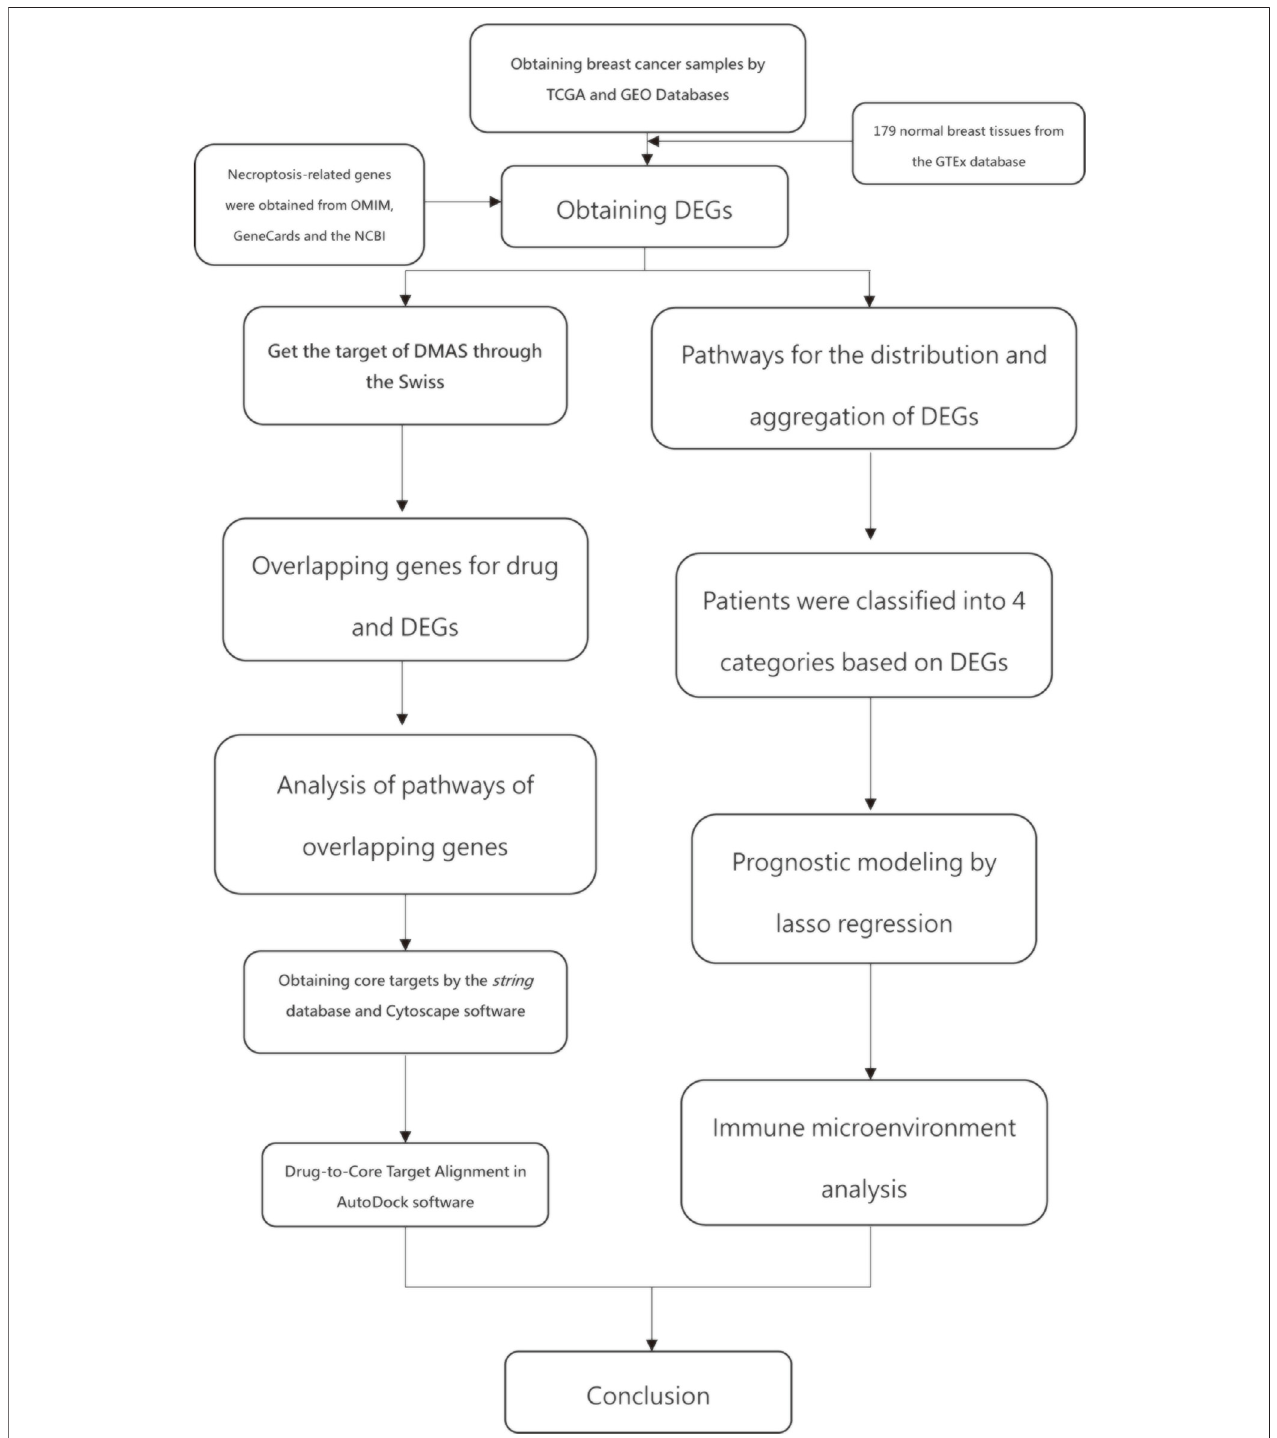
FIGURE 1 | work of fl ow in this